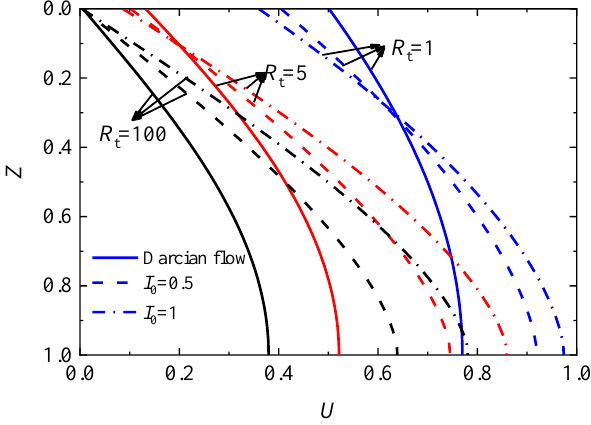
8 of 13 i.e., the greater the value of I 0 is, the more obvious the delay phenomenon of the pore pressure along with the depth is, which also indicates that the dissipation rate of pore pressure will be overestimated if the non-Darcy flow effect of flow is ignored. As also shown in Figures 7 and 8, the larger the boundary parameter R is, the stronger the bound- ary drainage capacity of impeded drainage boundaries and the faster the consolidation